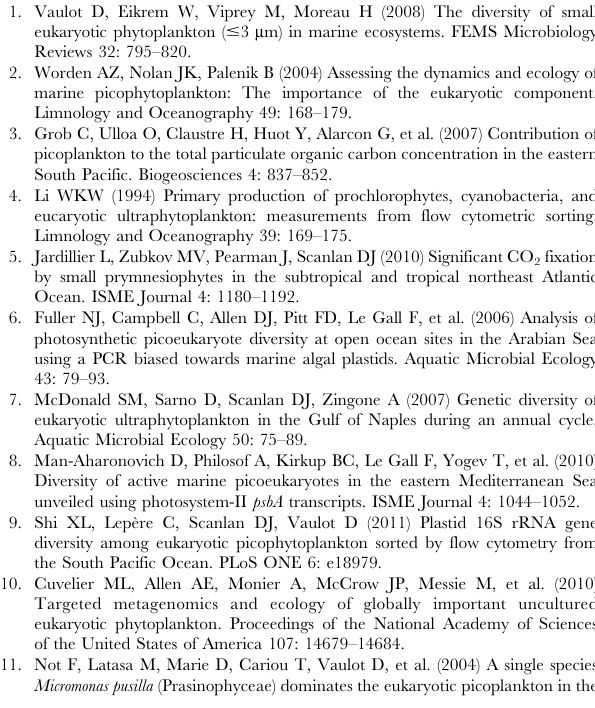
Table S6 Estimation of the number of major haplotypes and of their frequency for selected regions of genes with a high read coverage in both samples. Table S7 Genotype variability within the 5,646 bp rRNA operon. Positions are given along chromosome 11. Localisation of helix 3 of ITS2 follows Marin and Melkonian [39]. (PDF) Table S8 Assignment of reads for Pacific picoeukaryote samples T142 to individual chromosomes of O.’ luci- marinus’ using Geneious Assembler (see Materials and Methods for details). Table S9 List of reference genomes used for BLASTX analysis of contigs.